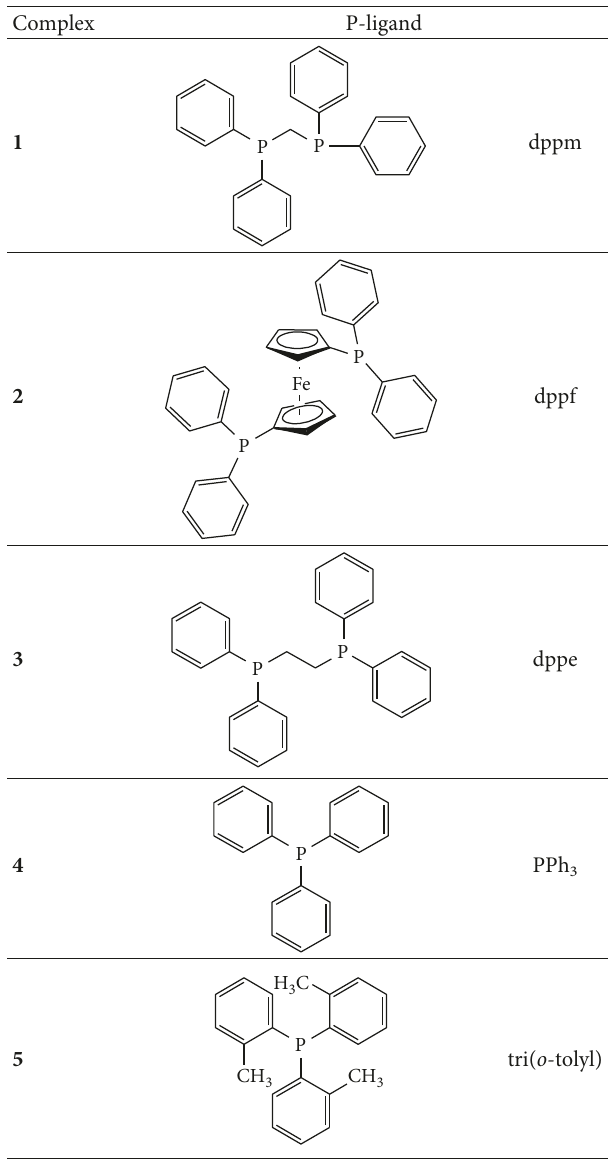
Table 1: The complexes with its phosphine